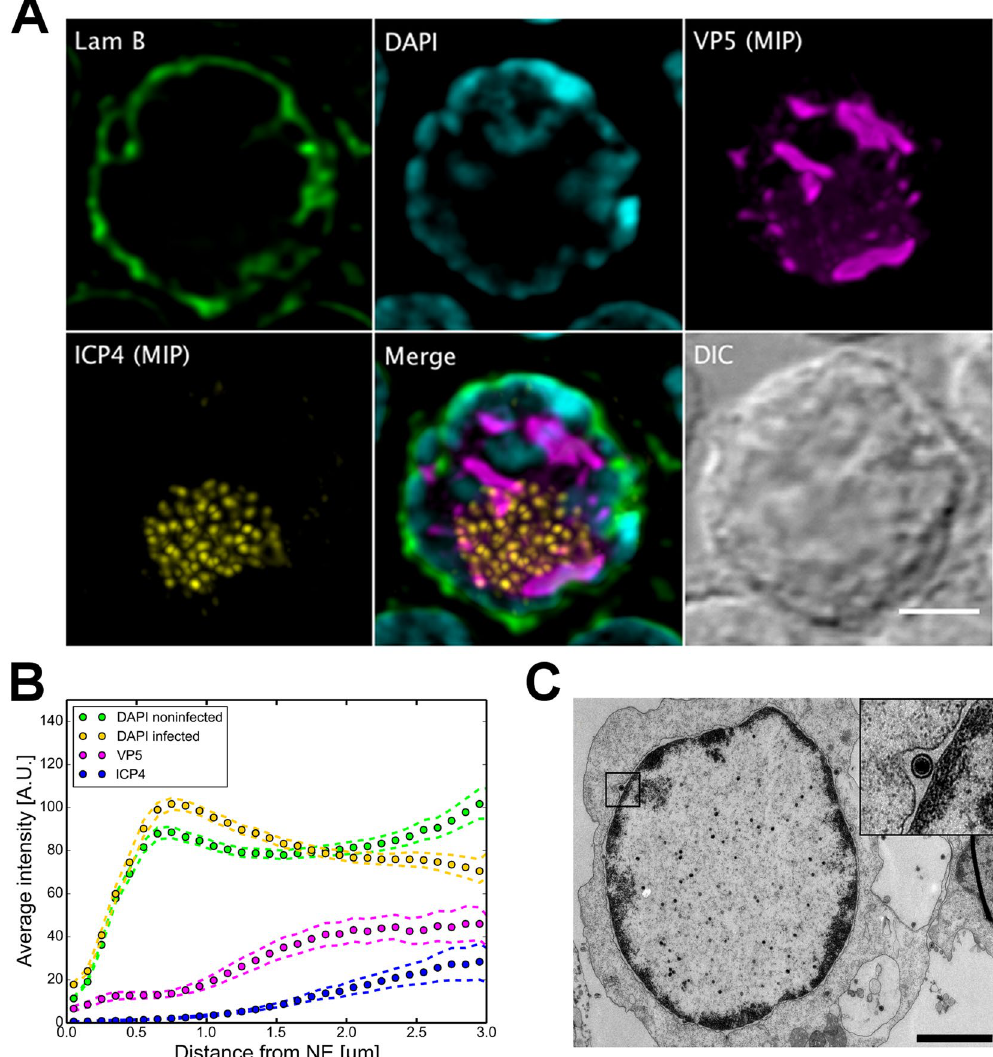
Figure 1. Nuclear distribution of host chromatin in infected cells with enlarged VRCs. ( A ) Confocal microscopy images showing the distribution of DAPI-labelled chromatin (cyan) and lamin B (green) together with maximum intensity projections (MIP) of viral EYFP-ICP4 (yellow) and VP5 (magenta) proteins at 24 h p.i. A differential interference contrast (DIC) image is also shown. Scale bar, 3 µ m. ( B ) The mean spatial distribution of chromatin in infected (n = 16) and non-infected (n = 20) cells together with VP5 and ICP4 shown as plots of the intensity at increasing distances from the NE. Dotted error lines represent the mean ± the standard error of the mean (SEM). ( C ) A TEM image of an infected cell nucleus at 24 h p.i. The inset shows an enlarged view of the boxed area containing the viral capsid in the space between the inner and outer leaflets of the nuclear membrane. Scale bar, 3 µ